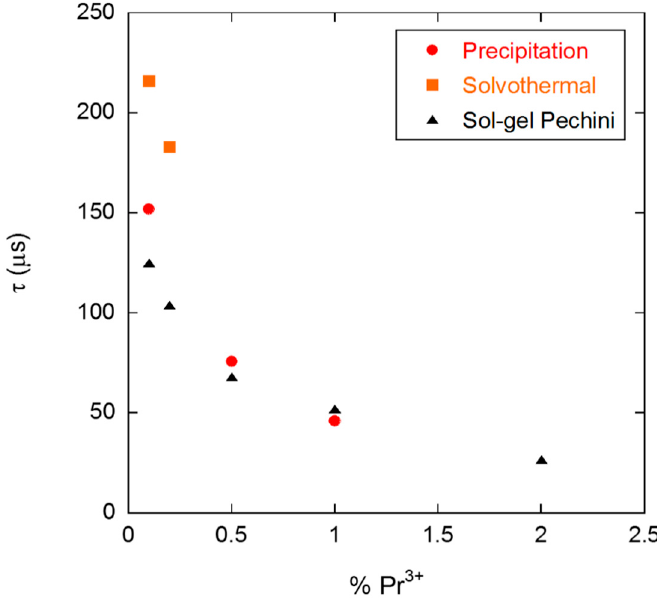
Figure 13. Dependence of the average lifetime on Pr 3 + concentration for NCs obtained through solvothermal, precipitation, and sol–gel Pechini methods.